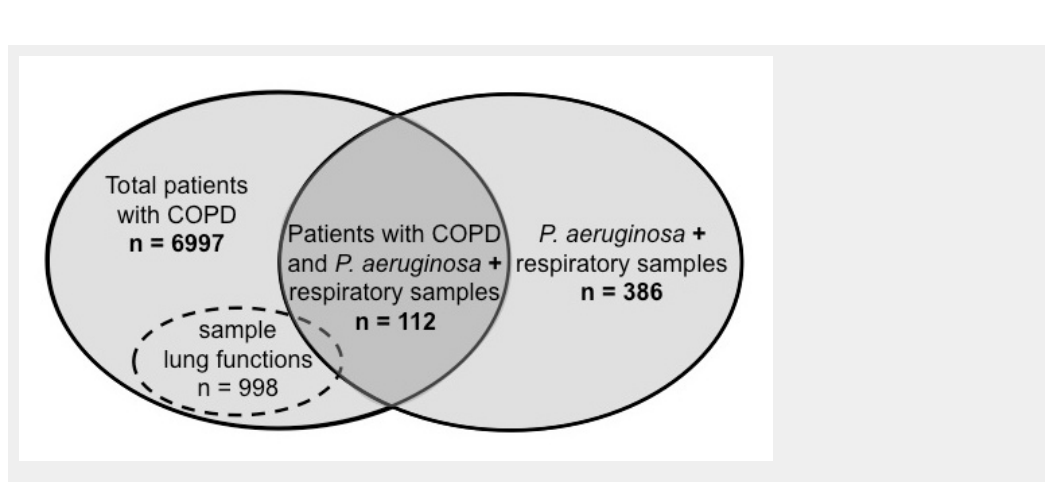
Overview of study population, sample lung function sub-population, and respiratory samples included in the analyses during the study period from 1 January 2004 to 31 December 2008. Total patients with COPD, patients either hospitalised or seen as outpatients between 1 January 2004 and 31 December 2008 at Bern University Hospital who had COPD as primary diagnosis or co-morbidity; lung functions, representative sample population of COPD patients who underwent lung function testing in the respiratory medicine department during the study period; P.